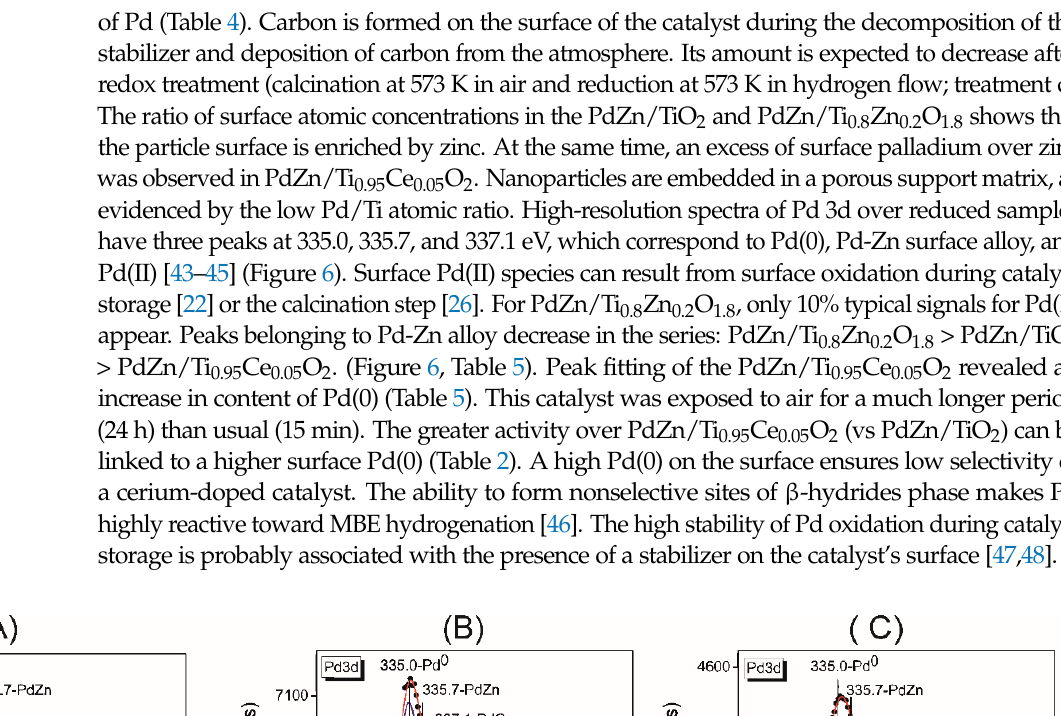
, PdZn/Ti 0.95 Ce 0.05 O 2 , and PdZn/Ti 0.8 Zn 0.2 O 1.8 after different pre- 2